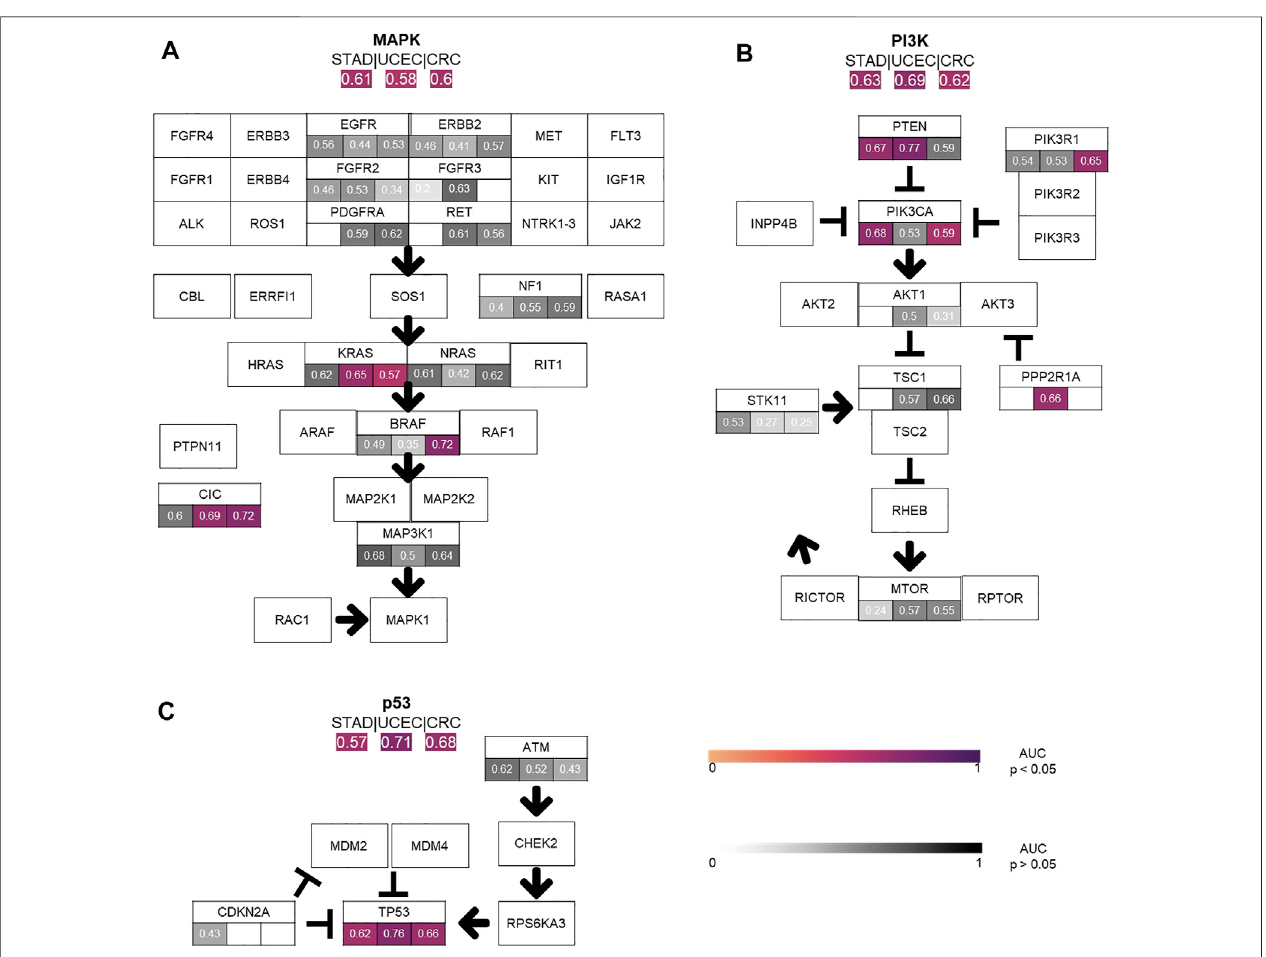
FIGURE3| Comparison ofthe performance ofthe single genearea under thereceiveroperating curve(AUROC) vs. pathway AUROC. The topthree pathways (A) MAPK, (B) PI3K, (C) TP53 AUROC results for the three top tumor cohorts (STAD, CRC, UCEC) are illustrated. AUROC values are compared between single gene vs. whole pathway. Coloured values stand for signi fi cantly detected pathways and grey for not signi fi cantly detected ( p > 0.05).